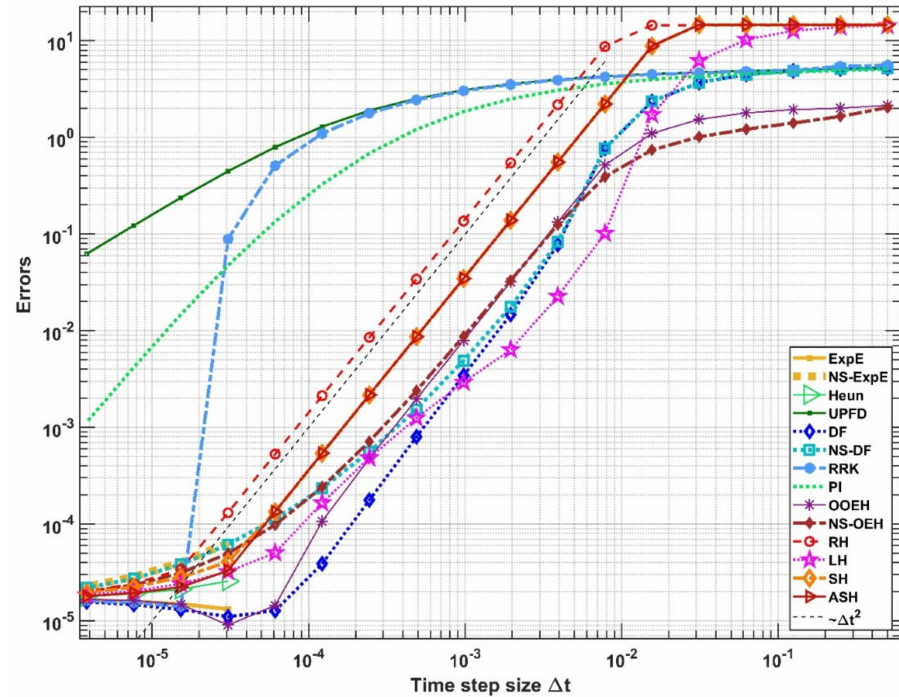
Figure 2. The L ∞ errors as a function of the time step size ∆ t for the 14 numerical schemes of Equation (2). The thin black dashed line is proportional to ∆ t 2 .